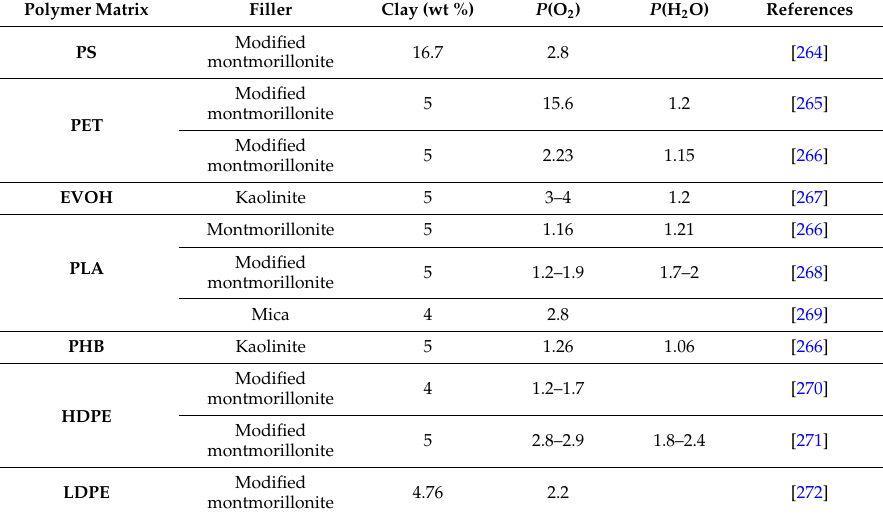
Table 3. Examples of polymer-clay nanocomposites and their barrier improvements. Permeabilities are expressed as improvement ratios: the ratio of the gas permeability or transmission rate of the virgin polymer to the gas permeability or transmission rate of the polymer-clay composite, measured at the same conditions